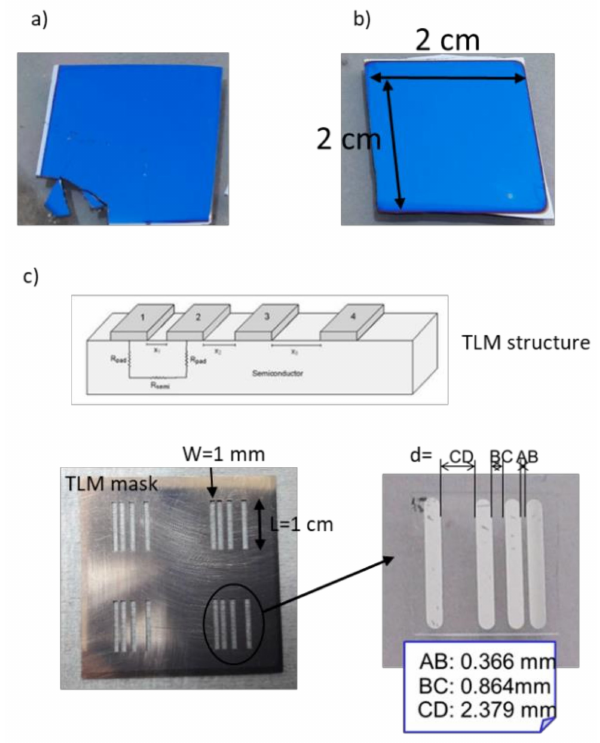
Figure 5. Photographs of hybrid transparent contacts based on TCO-coated silicon and ( a ) a graphene monolayer, ( b ) graphene bilayer on top and ( c ) TLM mask (on the left) and the TLM structure fabricated on graphene monolayer transferred onto quartz (on the